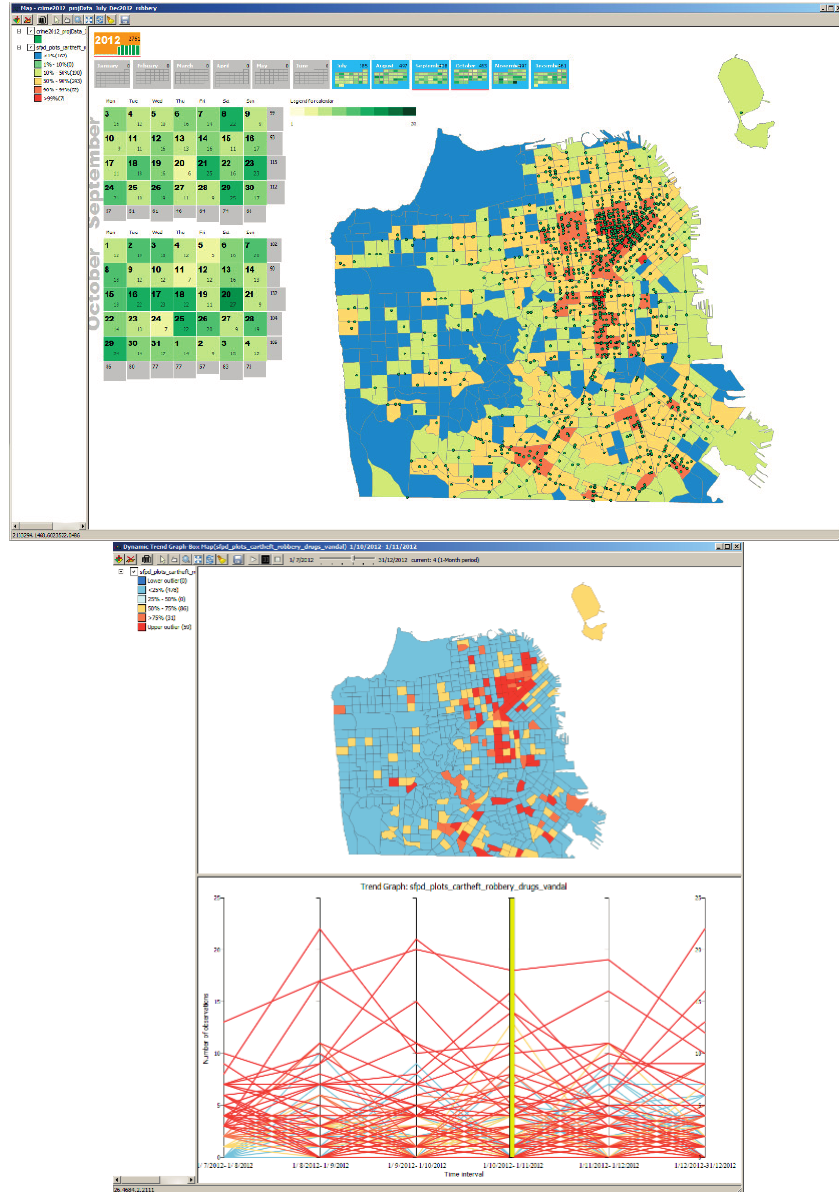
Figure 1. PySAL delivered as a stand-alone desktop application